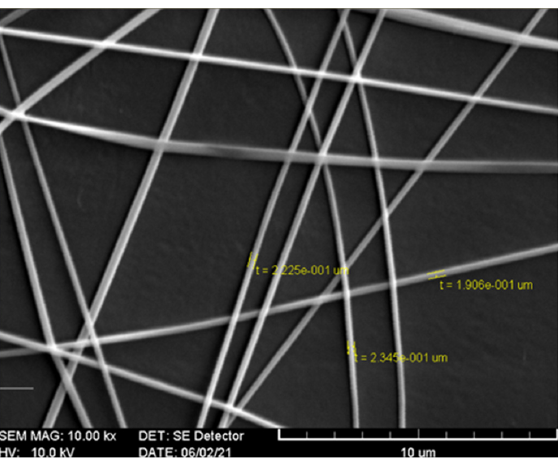
Figure 1. Scanning electron microscopy images of electrospun chitosan/polyvinyl alcohol/tetraethyl orthosilicate fibers on polypropylene film.